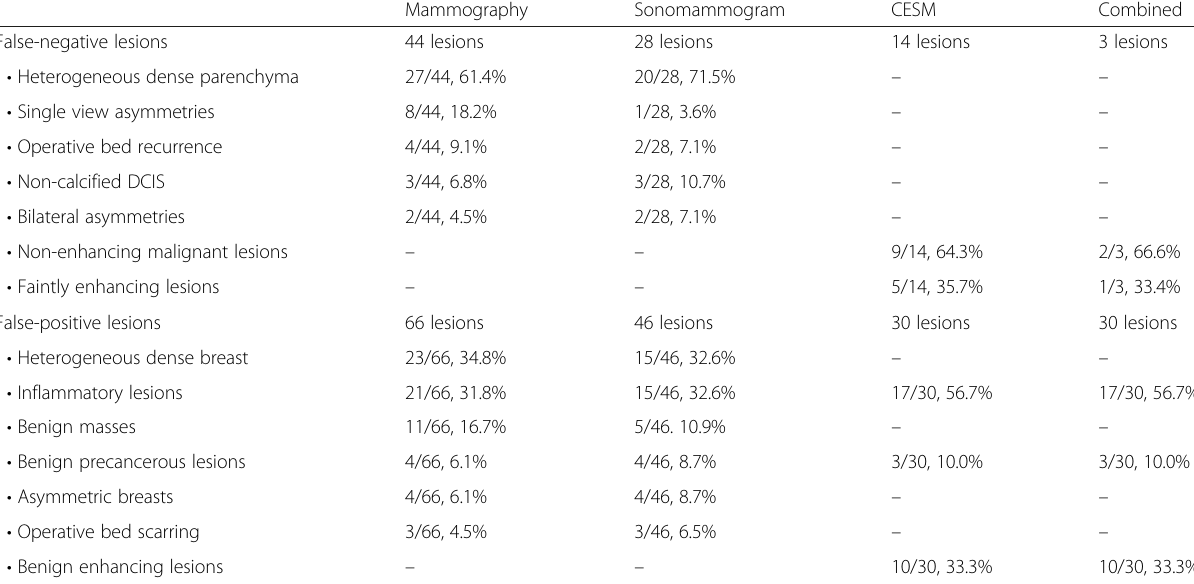
Table 3 Comparison between the number and frequency of the false-positive and false-negative lesions using the different imaging modalities